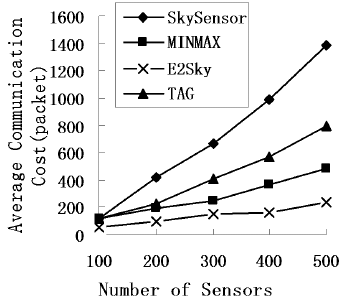
Figure 5. Average communications cost under a different number of sensors.